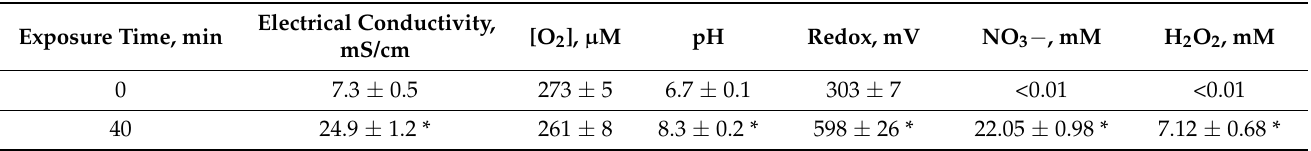
Table 1. Physicochemical properties of the PTS after treatment with high-frequency glow discharge of an aqueous solution of 0.1 M